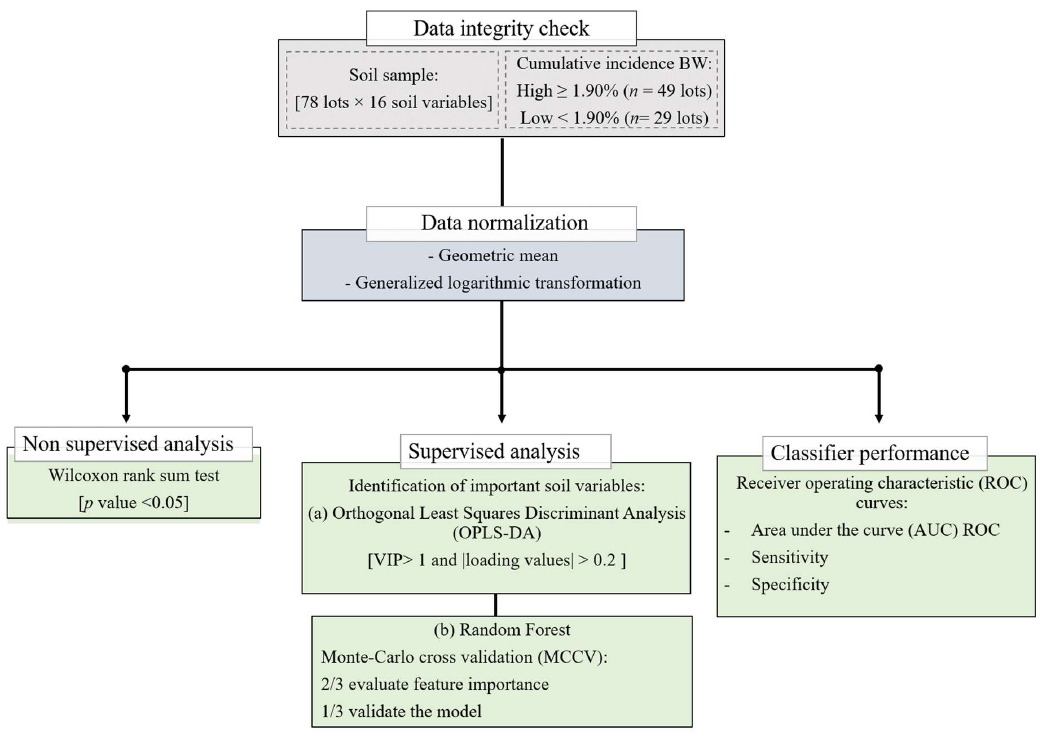
Figure 8. General scheme of the data analysis procedures (sample size, n = 78; variable size, n = 16) using non supervised and supervised analysis.